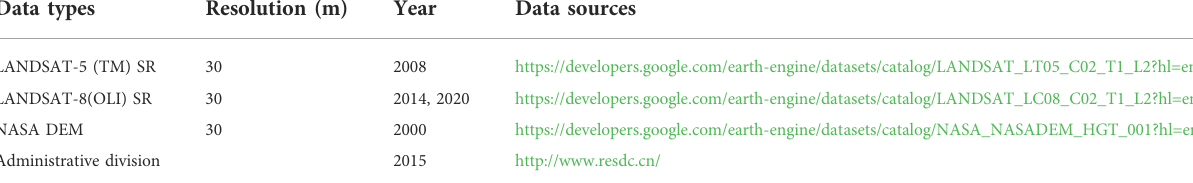
TABLE 1 Data source and description.